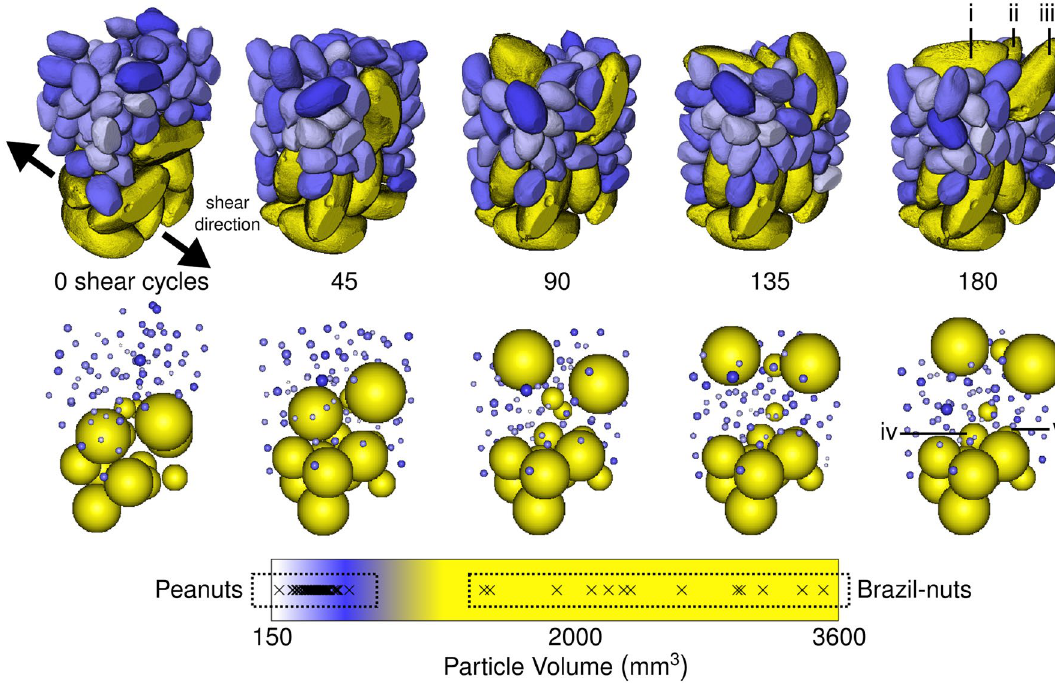
Figure 1. Temporal evolution of the sheared nut mixture, with nuts coloured according to their volume (top). Video V1 shows the full temporal evolution over 181 shear cycles. Point sphere representation of the nuts, false coloured according to their volume (middle). Colour bar, with volumes of all of the nuts marked with crosses